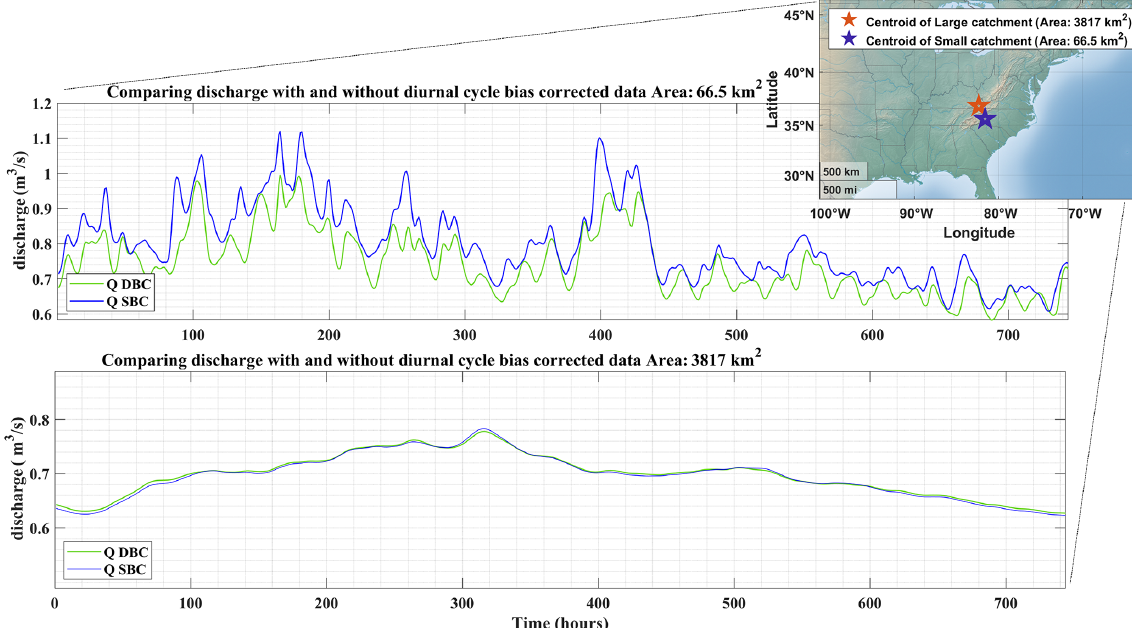
Figure 6. Hydrographs of two sampled catchments (small and large size surface area) for the month of July (744h = 31d × 24h).